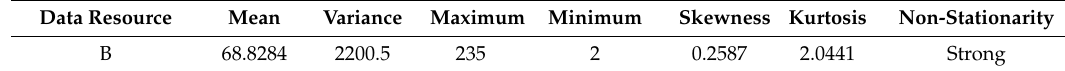
Table 4. The comparison results of di ff erent methods